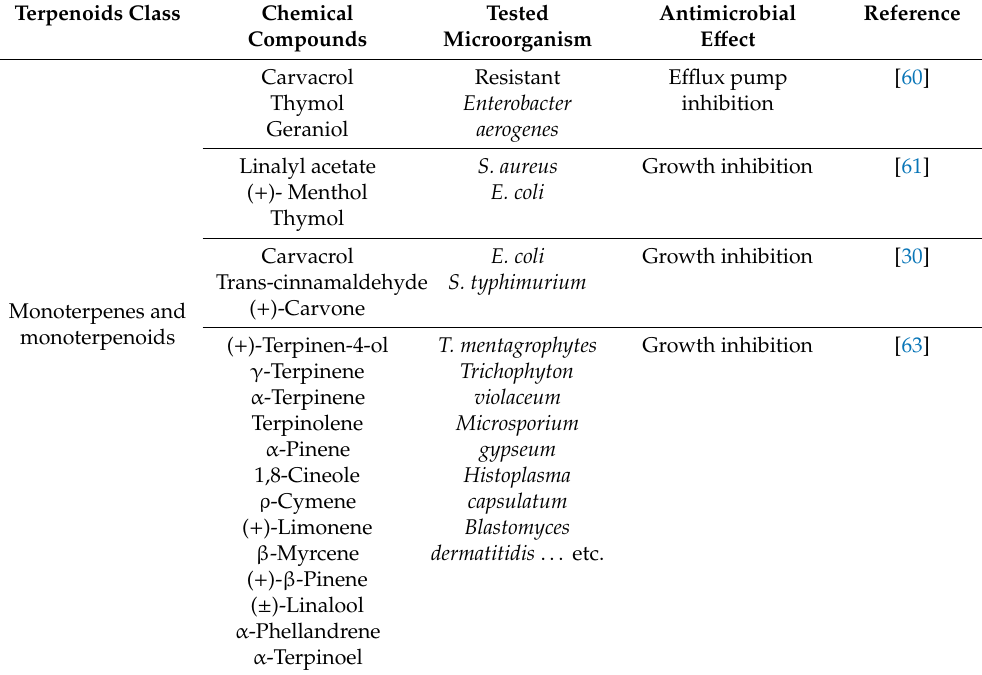
Table 2. Summary of antimicrobial activity e ff ects of some terpenoid